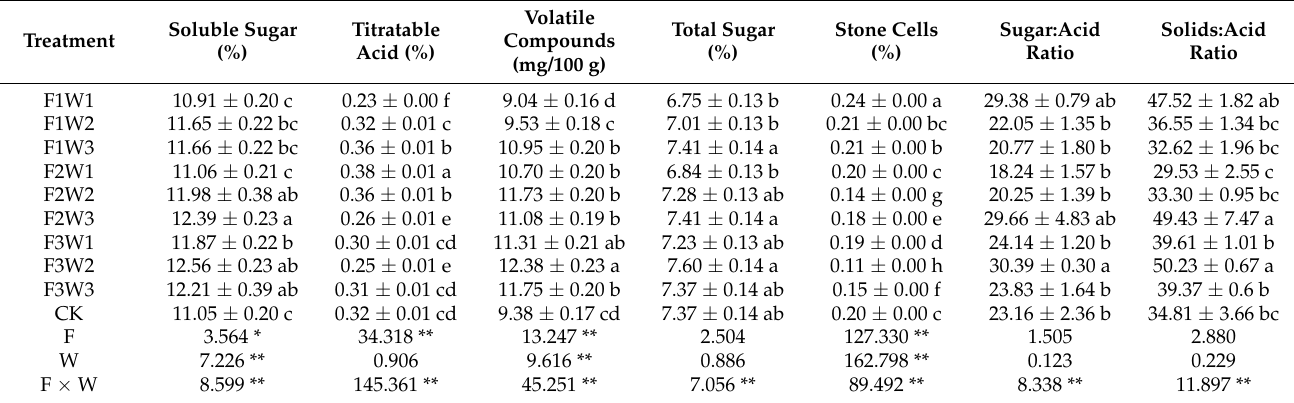
Table 5. Changes (mean ± standard error) in flavor and quality of fragrant pear under different methods and volumes of